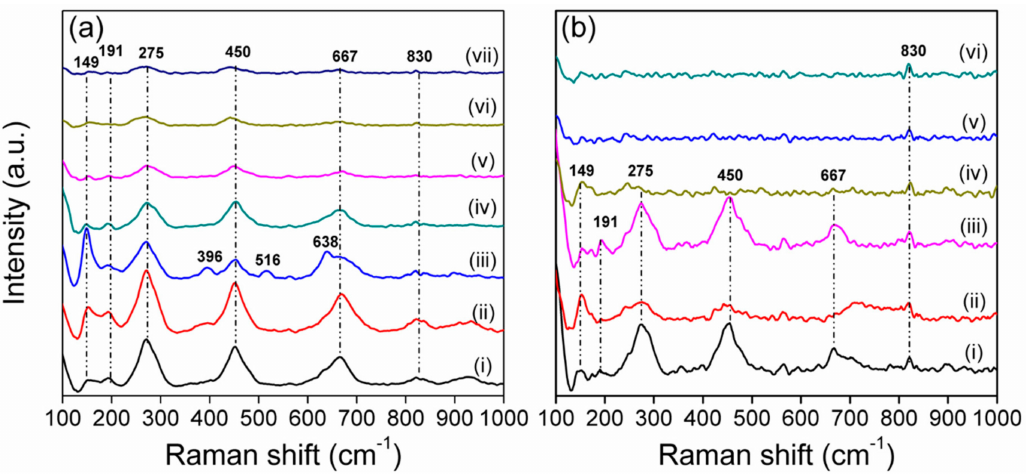
Figure 3. ( a ) Raman spectra of (i) pure TNTs, (ii) Ag / TNT-1_SH, (iii) Ag / TNT-5_SH, (iv) Ag / TNT-2.5_AM, (v) Ag / TNT-100_AM, (vi) Ag / TNT-2.5_IN, and (vii) Ag / TNT-100_IN. ( b ) Raman spectra of (i) Ag / TNT-2.5_NB, (ii) Ag / TNT-100_NB, (iii) Ag / TNT-2.5_EL (0.1), (iv) Ag / TNT-100_EL (0.1), (v) Ag / TNT-2.5_EL (1), and (vi) Ag / TNT-100_EL (1).